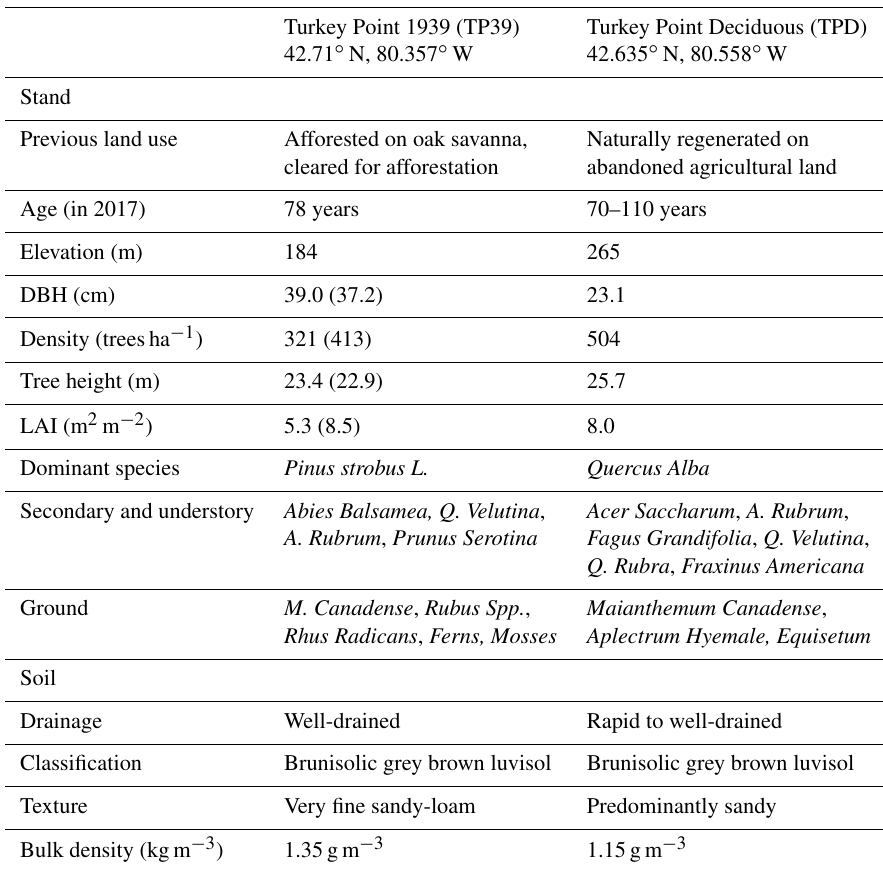
Table 1. Site characteristics of the deciduous (TPD) and coniferous (TP39) forest stands. The TP39 values in brackets indicate pre-thinning (2003–2011) values, prior to the period of